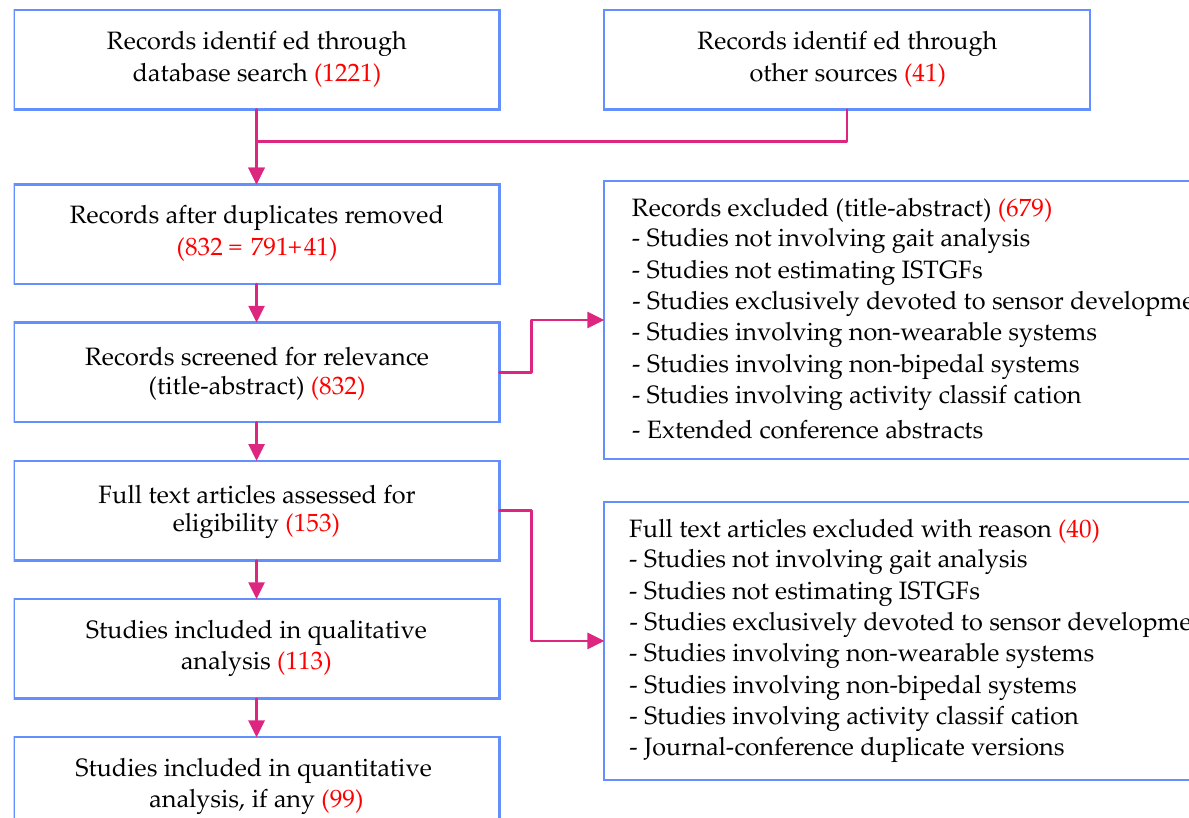
Figure 3. PRISMA flow diagram illustrating the screening procedure. Reasons for exclusion and the number of articles retrieved at each stage are indicated in red. In addition, 832 articles were left after removing duplicates. Out of those, 679 articles were eliminated through title-abstract screening, based on a set of exclusion criteria as listed in the PRISMA flow diagram. The remaining 153 articles qualified for full-text screening, of which 40 were excluded and the remaining 113 qualified for full-text review. Out of these, 99 articles were also used for quantitative analysis. ISTGF—intra-stride temporal gait